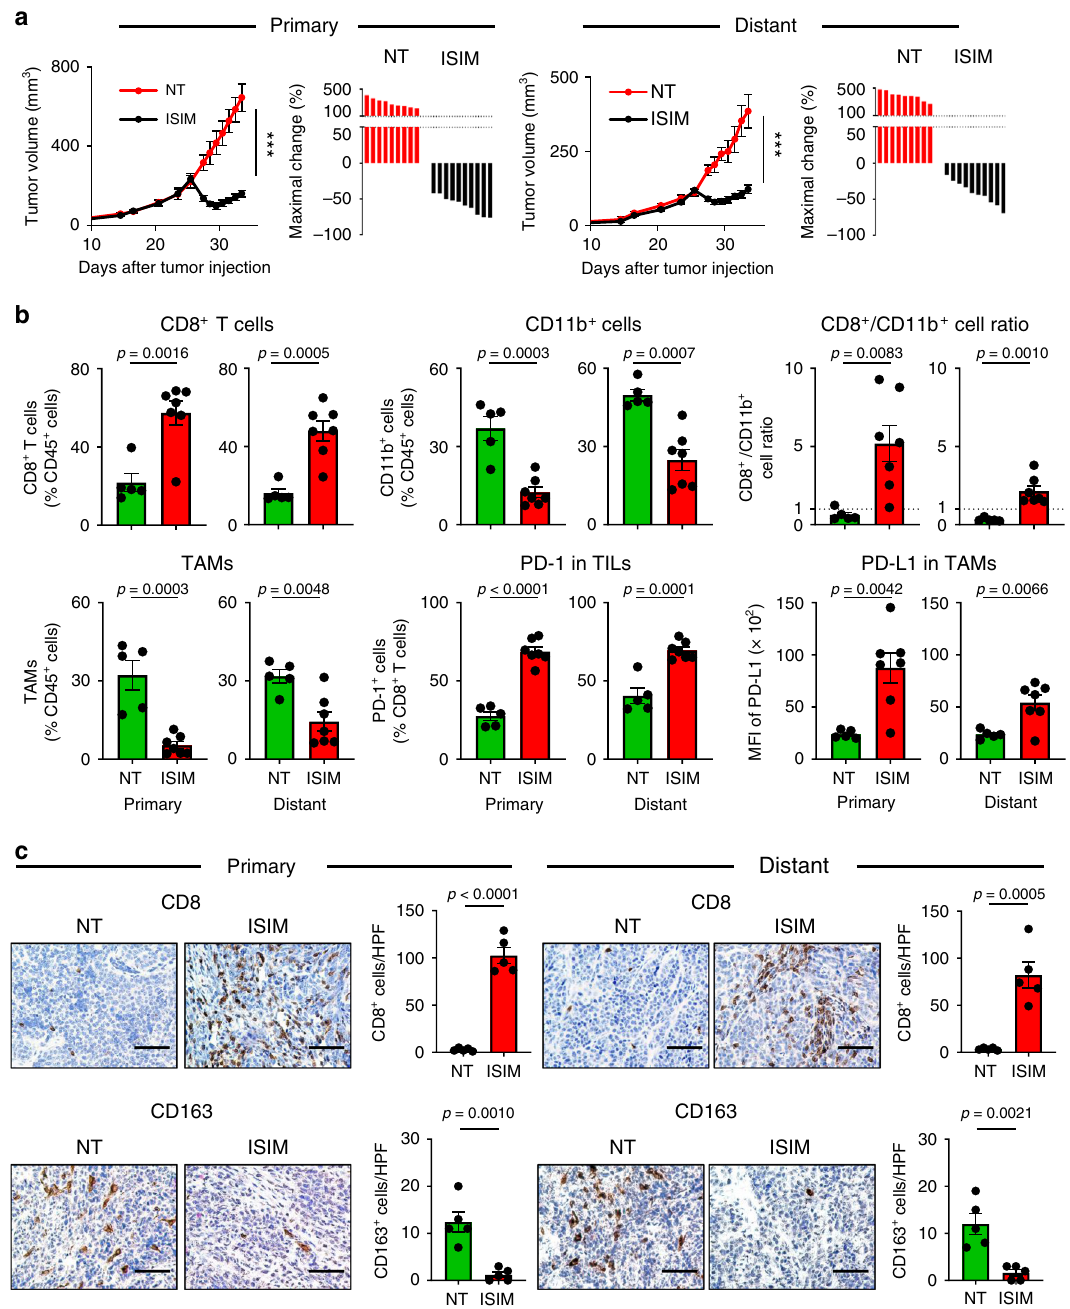
Fig. 5 In situ immunomodulation (ISIM) of primary tumors triggers the immune remodeling and regression of untreated distant tumors. a Tumor growth curves (mean) and waterfall plots of primary and untreated distant tumors of AT-3 tumor-bearing mice treated with or without ISIM. n = 9 mice (NT) and 10 mice (ISIM). Waterfall plots show maximal change of tumor volume at the day when TLR3/CD40 agonists were administered. *** p <0.001 by a two- tailed t -test. b Frequency of CD8 + T cells, CD11b + cells among CD45 + cells, and CD8 + T cell/CD11b + cell ratio, frequency of tumor-associated macrophages (TAMs: Ly6c − class II + CD24 − F4/80 + ) of CD45 + cells, percentage of PD-1 + cells in CD8 + TILs, and median fl uorescence intensity (MFI) of PD-L1 in TAMs in primary and distant tumors treated with or without ISIM to primary tumors. n = 5 mice (NT) and 7 mice (ISIM). c Representative images of immunohistochemistry for CD8 and CD163 in the primary and untreated distant AT-3 tumors. Scale bars, 100 μ m. Data panels show mean numbers of CD8- and CD163-positive cells per each high-power fi eld (HPF) within fi ve different areas. Tumors were harvested 7 days after TLR3/CD40 stimulation ( b , c ). Two- tailed t -test. Mean±SEM. Data shown are representative of two independent experiments. Source data are provided as a Source Data fi